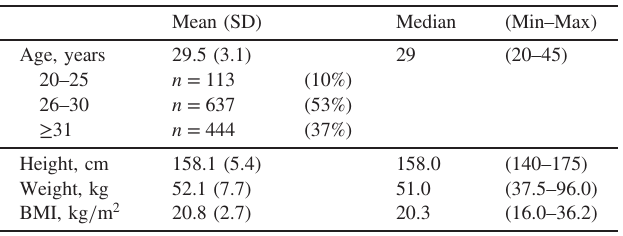
Table 1. Demographic characteristics of mothers ( n = 1,194)